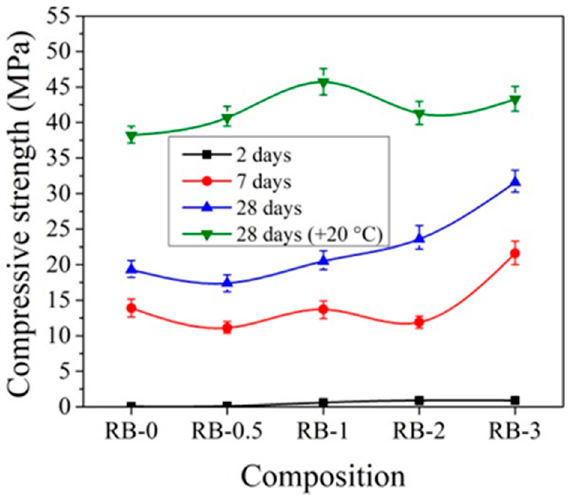
Figure 17. Compressive strength of concrete with CEM IIR samples at − 10 °C initial curing (28 days (+20 °C)—reference samples prepared and cured at +20 °C).